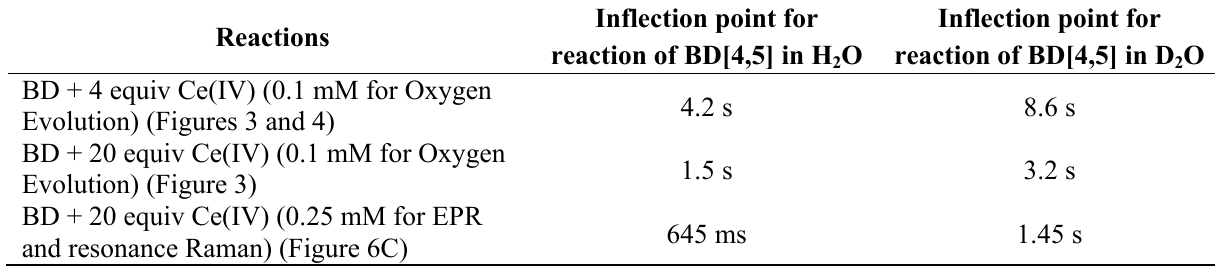
Table 3. Inflection points from the reaction of 0.1 mM BD[3,3] + 4 equiv and 20 equiv